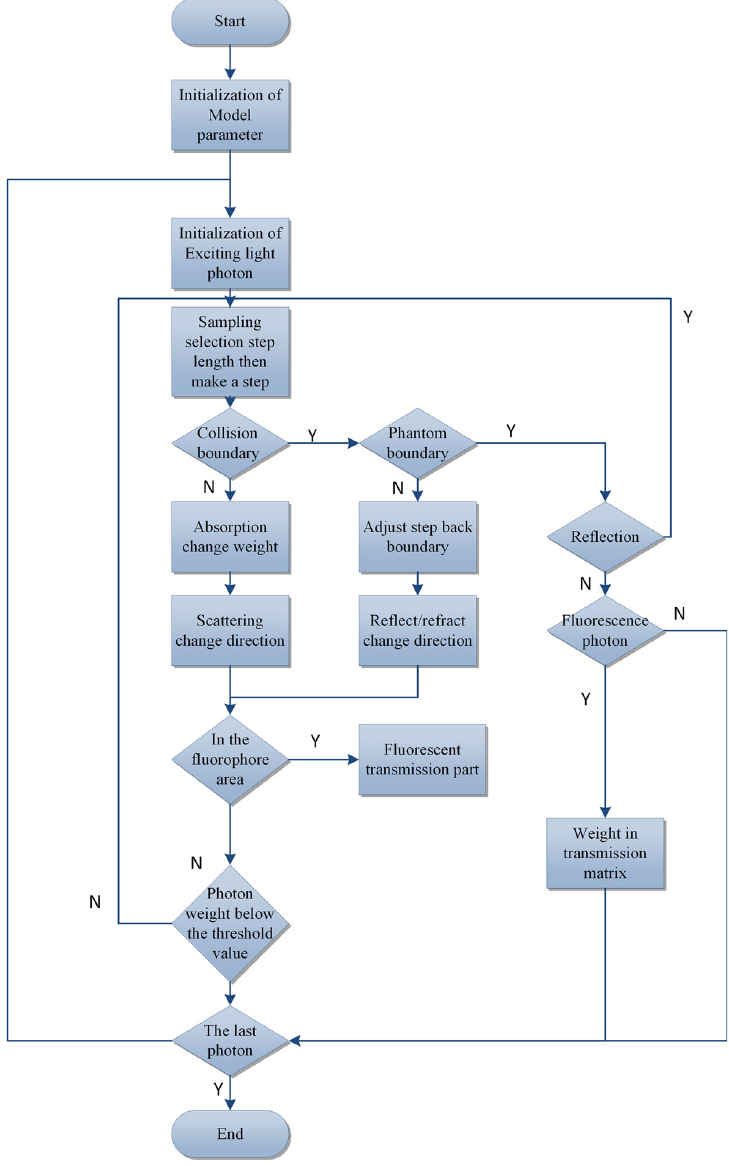
Fig. 2. Flowchart of ISEFMT with the Monte Carlo